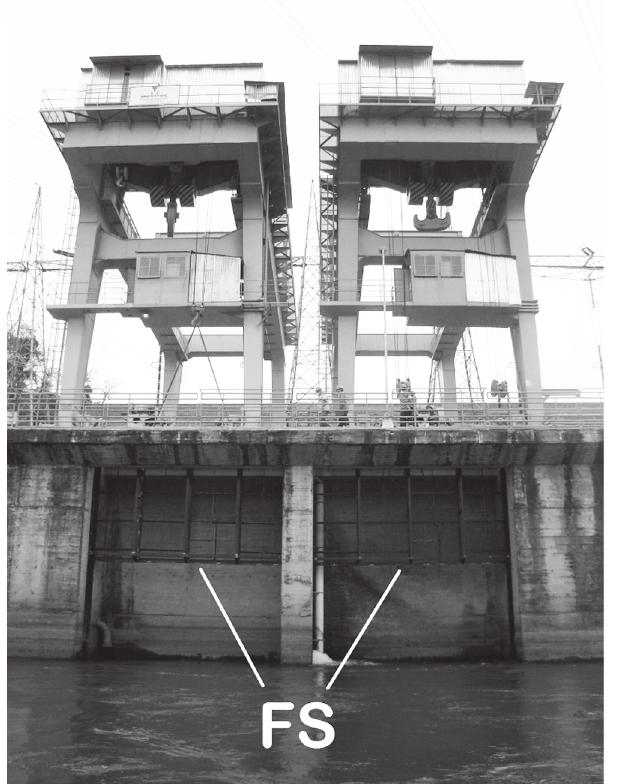
Fig. 2. Fish screens (FS) used to block the entrance of mandi into the draft tube of Três Marias Dam during turbine stop/ startup.